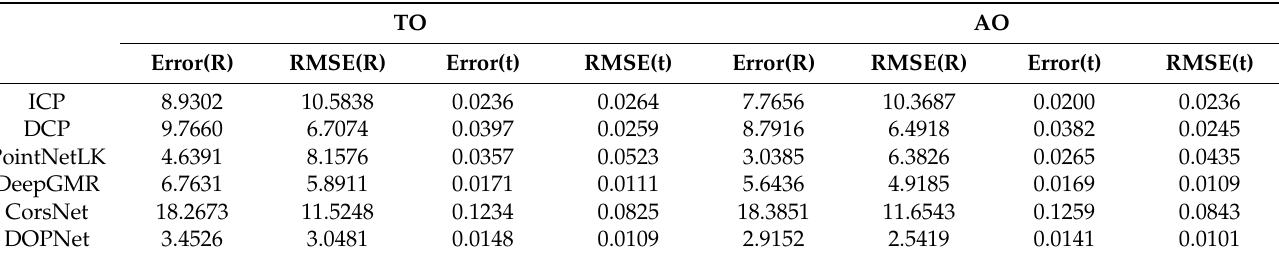
Table 2. Test on unseen